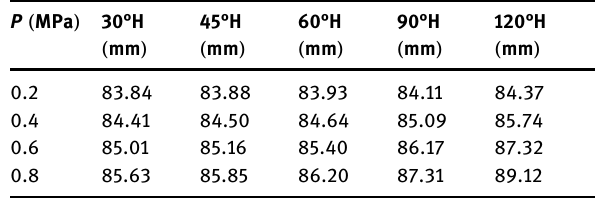
Table 4: Maximum deformation heights of bump at di ff erent angles